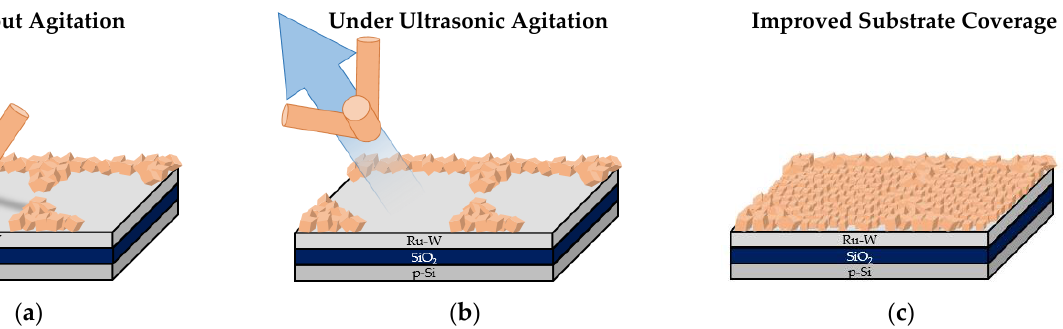
Figure 10. Electrocrystallisation model for Cu on Ru–W thin films with and without ultrasonic agitation. Incomplete substrate coverage around large Cu particles without ultrasonic agitation ( a ), Cu particle detachment via mechanical stimulus ( b ), and filling of the coverage gaps after Cu particle removal ( c ).